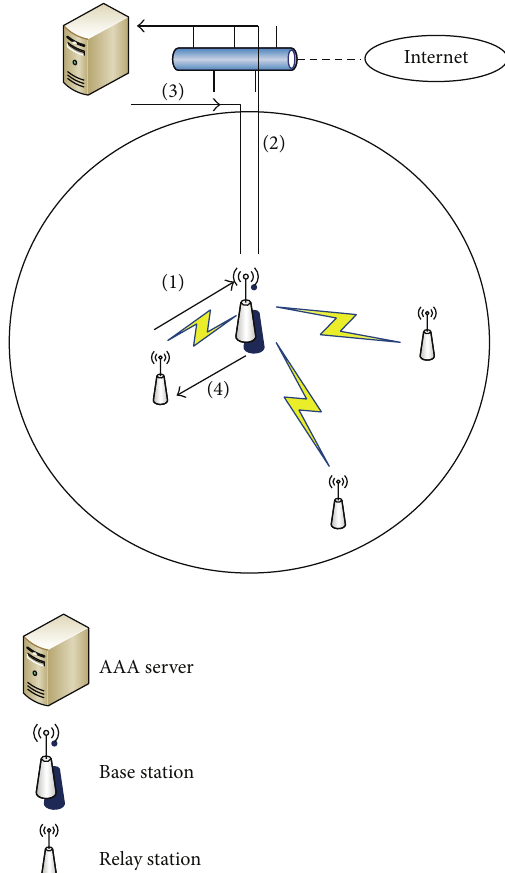
Figure 1: RS connects to MMR networks via